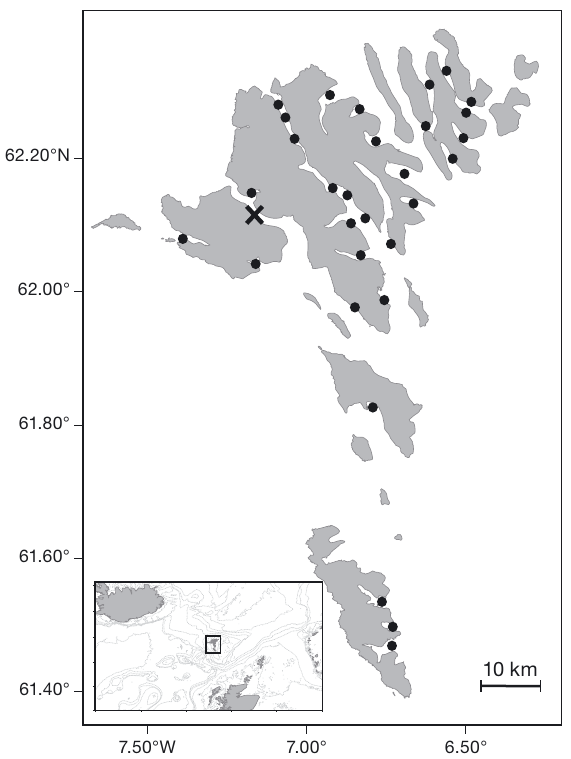
Fig. 1. Faroese farm locations (black circles) and location of temperature measurements (black